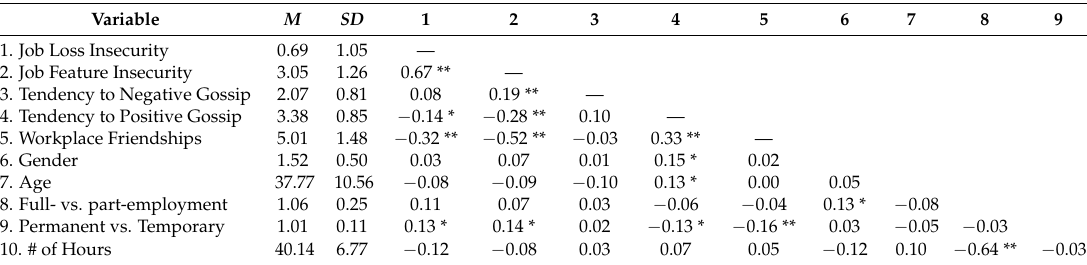
Table 1. Descriptive statistics and interscale correlations of study variables.